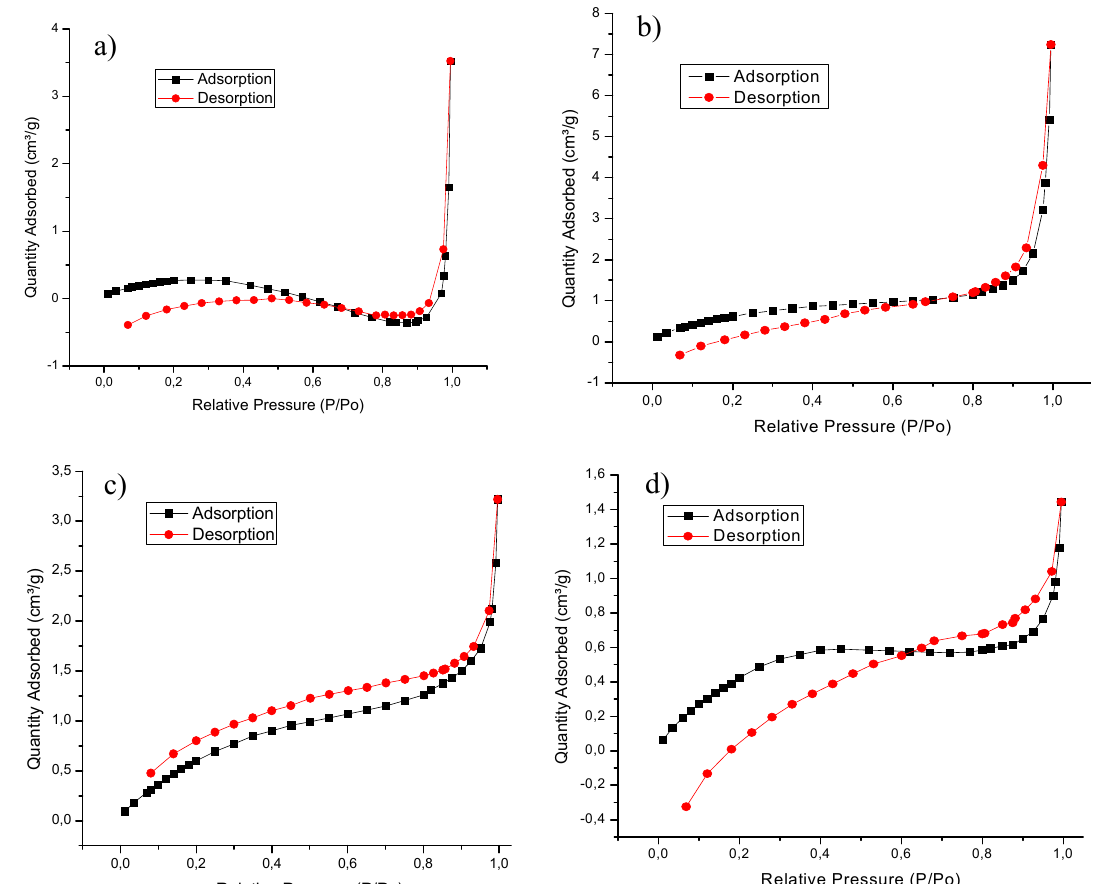
Figure 2. Adsorption-desorption isotherm for: ( a ) yam peels, ( b ) oil palm bagasse, ( c ) banana peels,